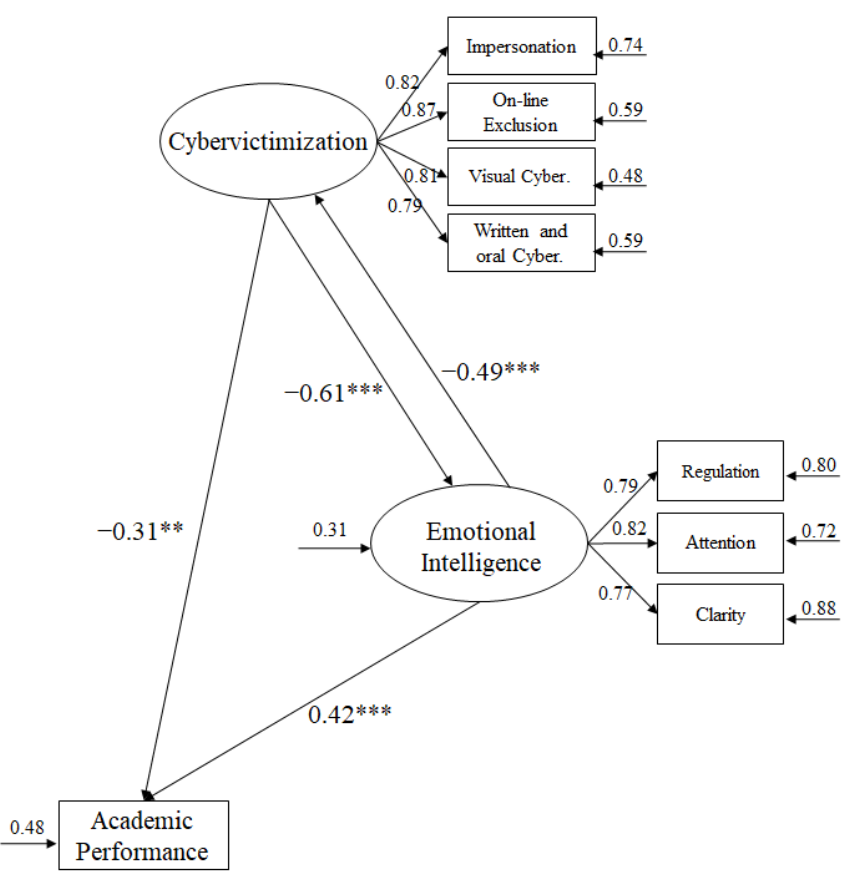
Figure 1. Structural equation model. The explained variances are shown on the small arrows. All